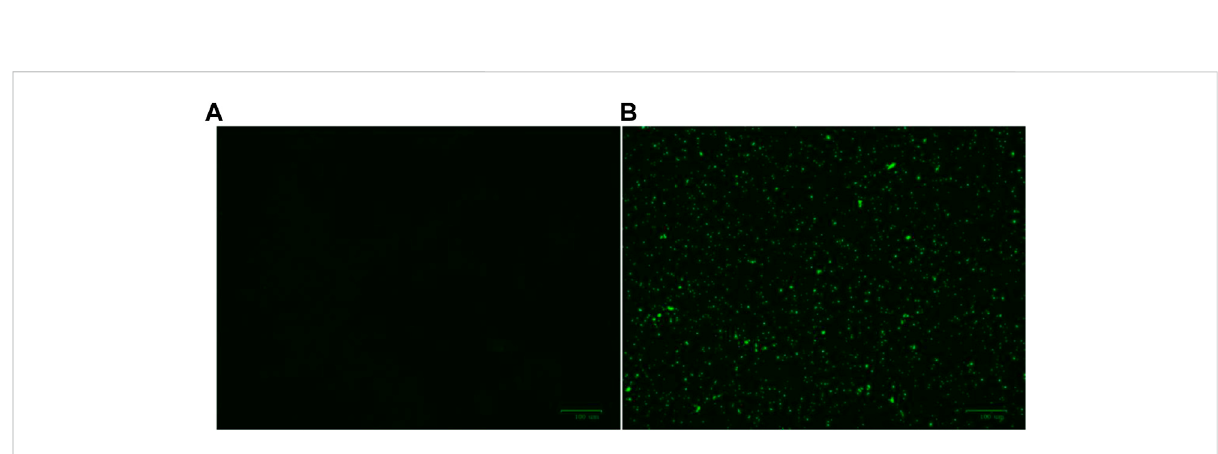
FIGURE 10 Effect of membrane depolarization (A) The blank control was bacteria without drug treatment. (B) Staphylococcus aureus treated with Ru-3 (4 μ g ml − 1 ) for 2